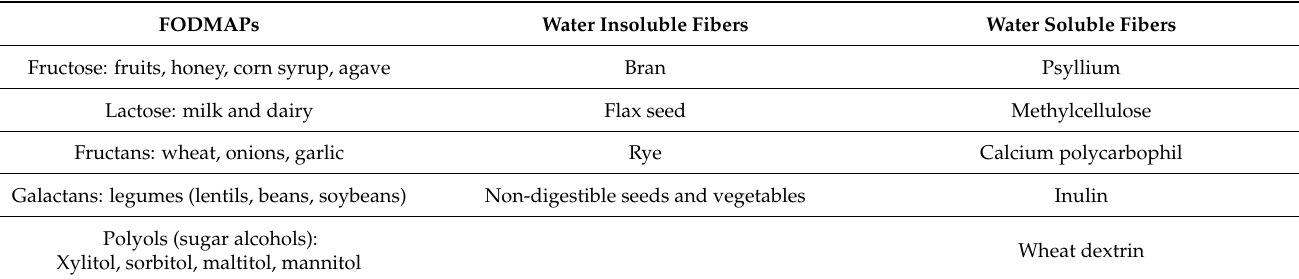
Table 1. Types of FODMAPs and dietary